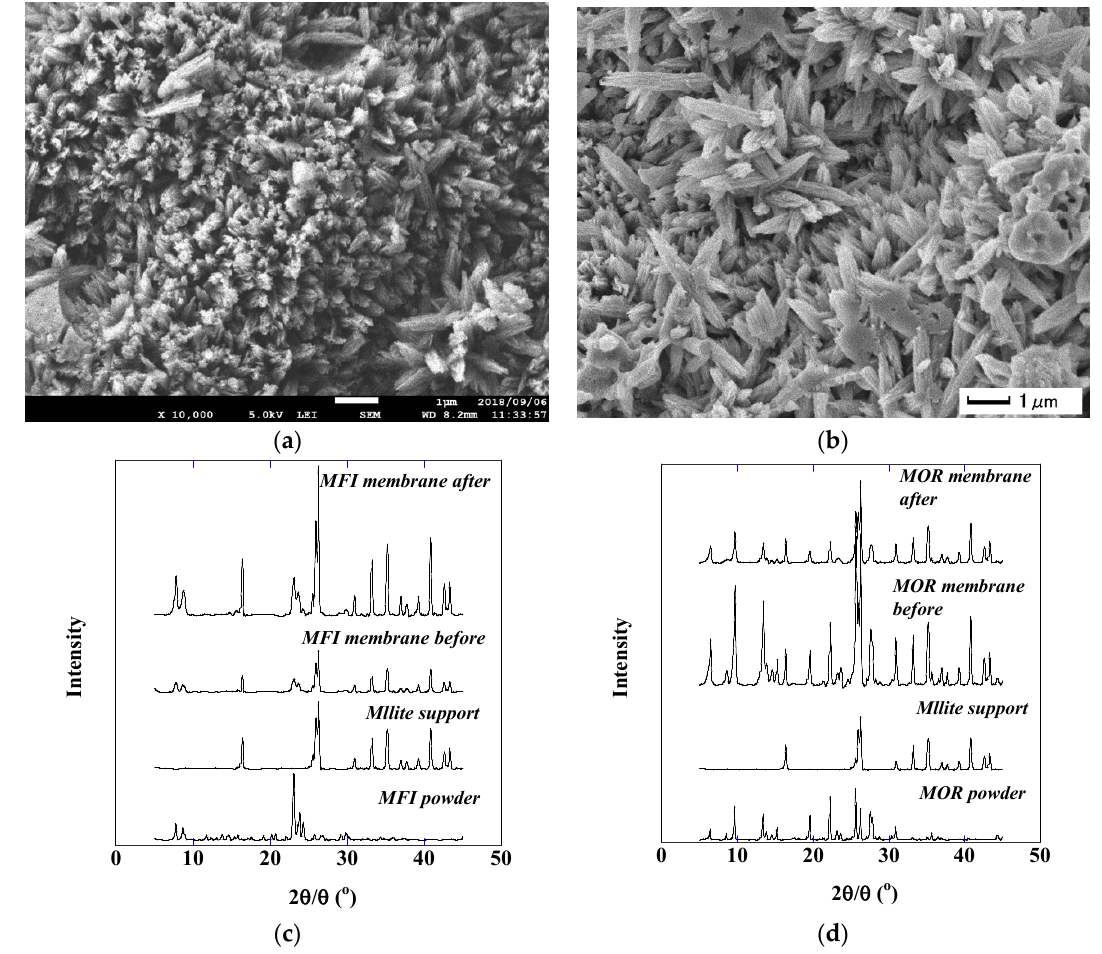
Figure 4. Membrane morphologies: ( a ) fresh MFI membrane surface; ( b ) MFI membrane surface after treatment; ( c ) XRD patterns of MFI membrane; ( d ) XRD patterns of MOR membrane.